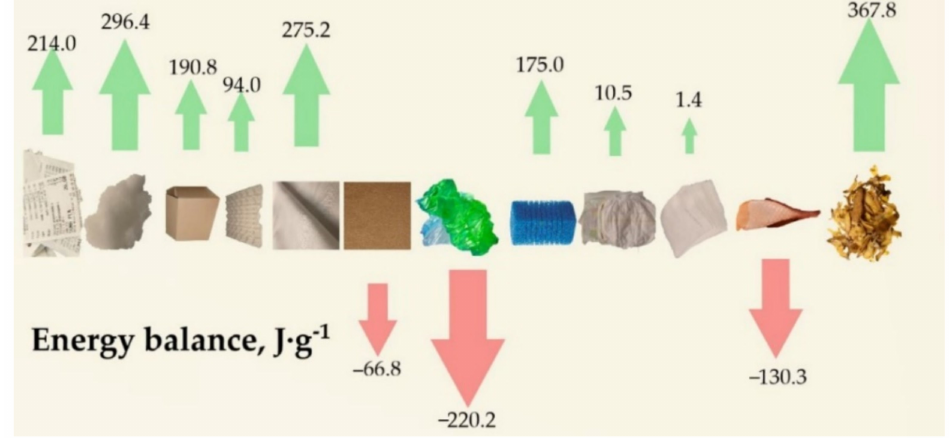
Figure 13. Energy balance of transformations occurring during pyrolysis for different